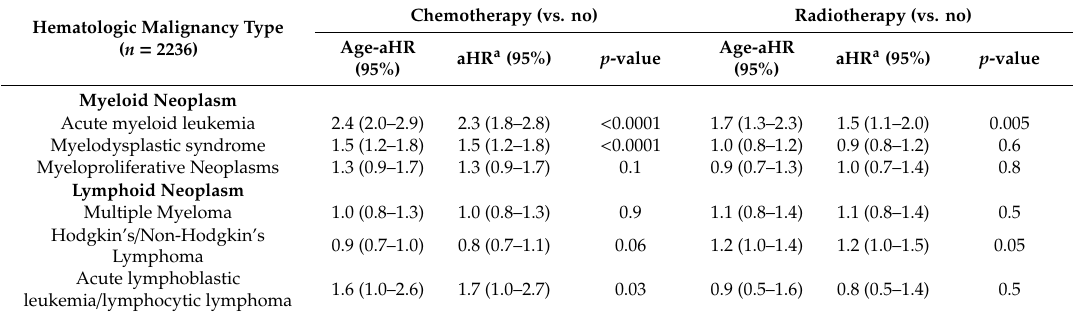
Table 4. Risk of hematologic malignancies (HRs) in patients exposed to chemotherapy and radiotherapy. Hematologic Malignancy Type ( n =